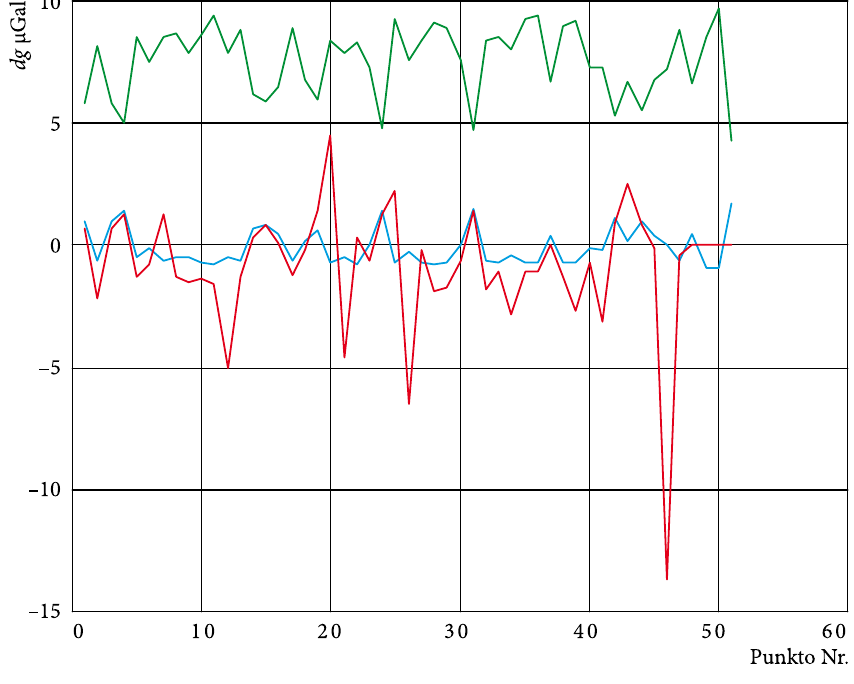
Fig. 2. Difference of gravity value ( dg 21 — , dg 23 — , dg 24 —